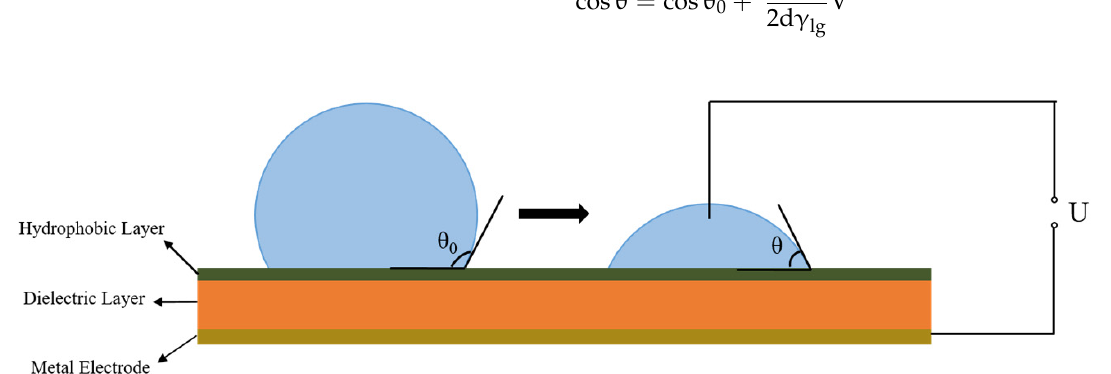
Figure 1. Typical structure of an electrowetting on dielectric (EWOD) device and the change in shape of droplets when voltage is applied.